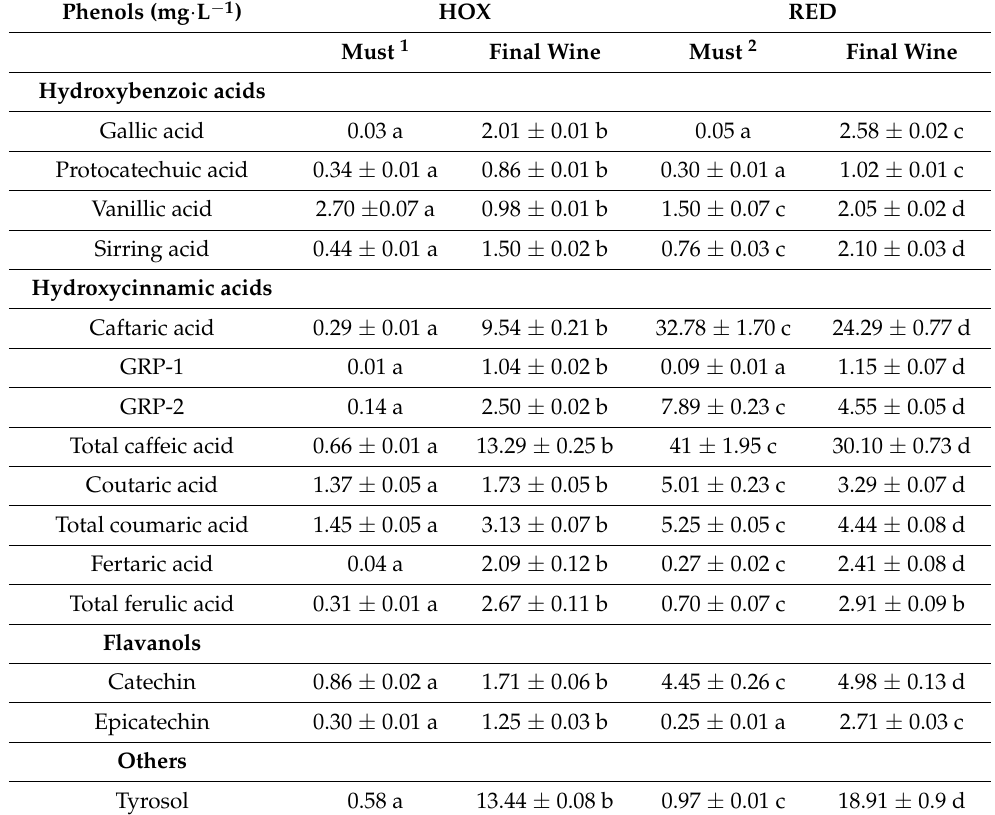
Table 3. Mean value of concentration of selected phenolic compounds in musts and final wines (mg · L − 1